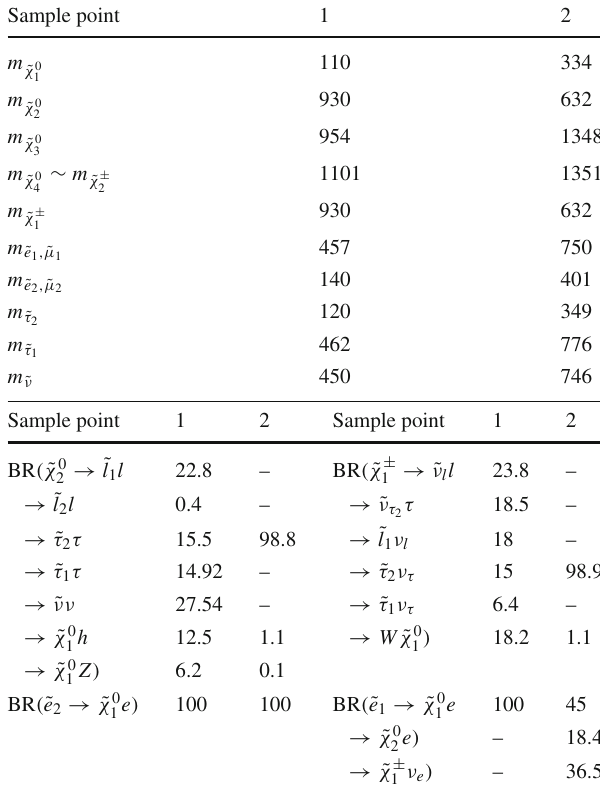
Table 4 The masses (in GeV) and relevant BRs (%) of two sample points from ˜ l ± -coannihilation Case-R scenario. Here we show the BRs of ˜ χ ± and ˜ χ 0 to third generation sleptons separately and that of the first 2 1 two generations together. Therefore, ˜ l refers to ˜ e and ˜ μ together. ν is used to indicate ν e , ν μ and ν τ